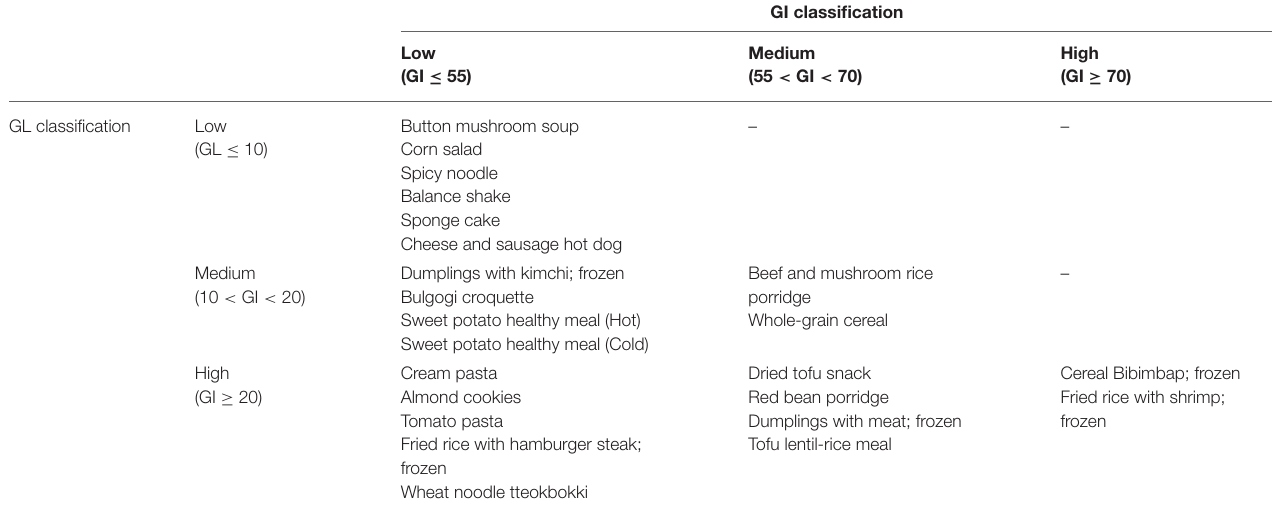
TABLE 5 | Classification between measured GI and GL for one serving of provided